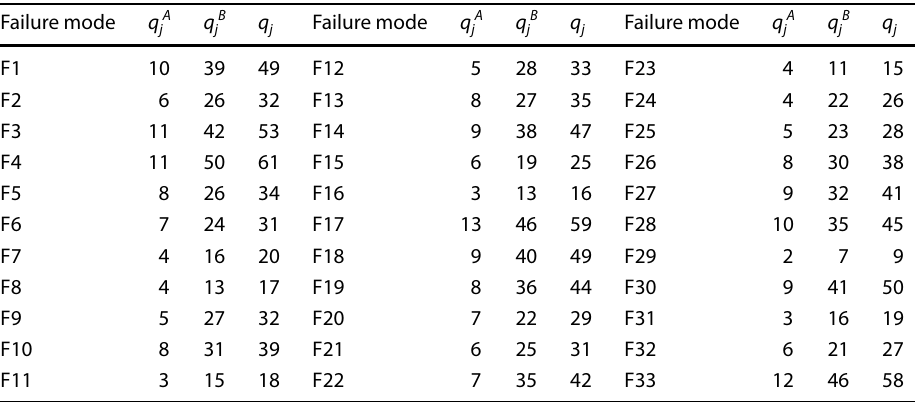
Table 5 Number of repetitions of each failure mode